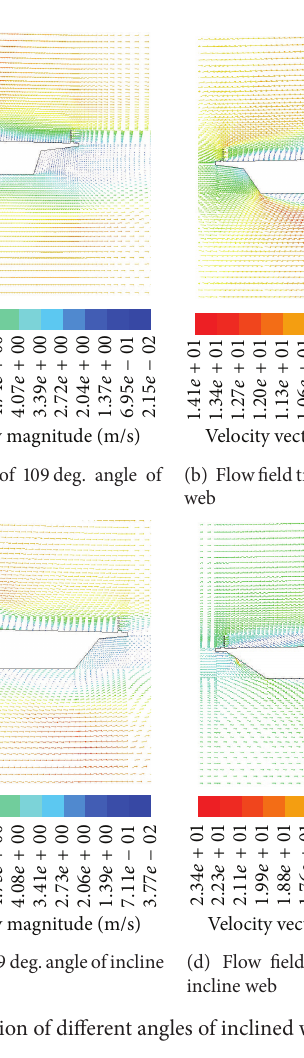
little difference between air pressures around the girder.